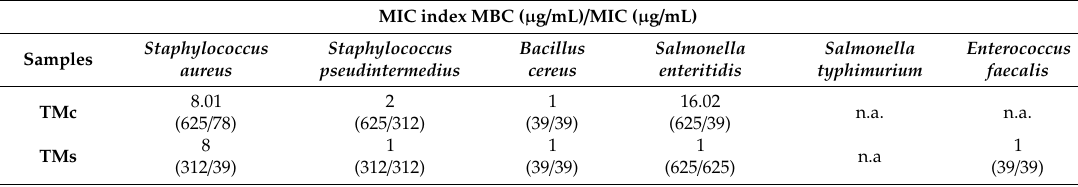
Table 4. Minimum inhibitory concentration (MIC) index calculated as the ratio of the MICs and Minimum bactericidal concentrations (MBCs)